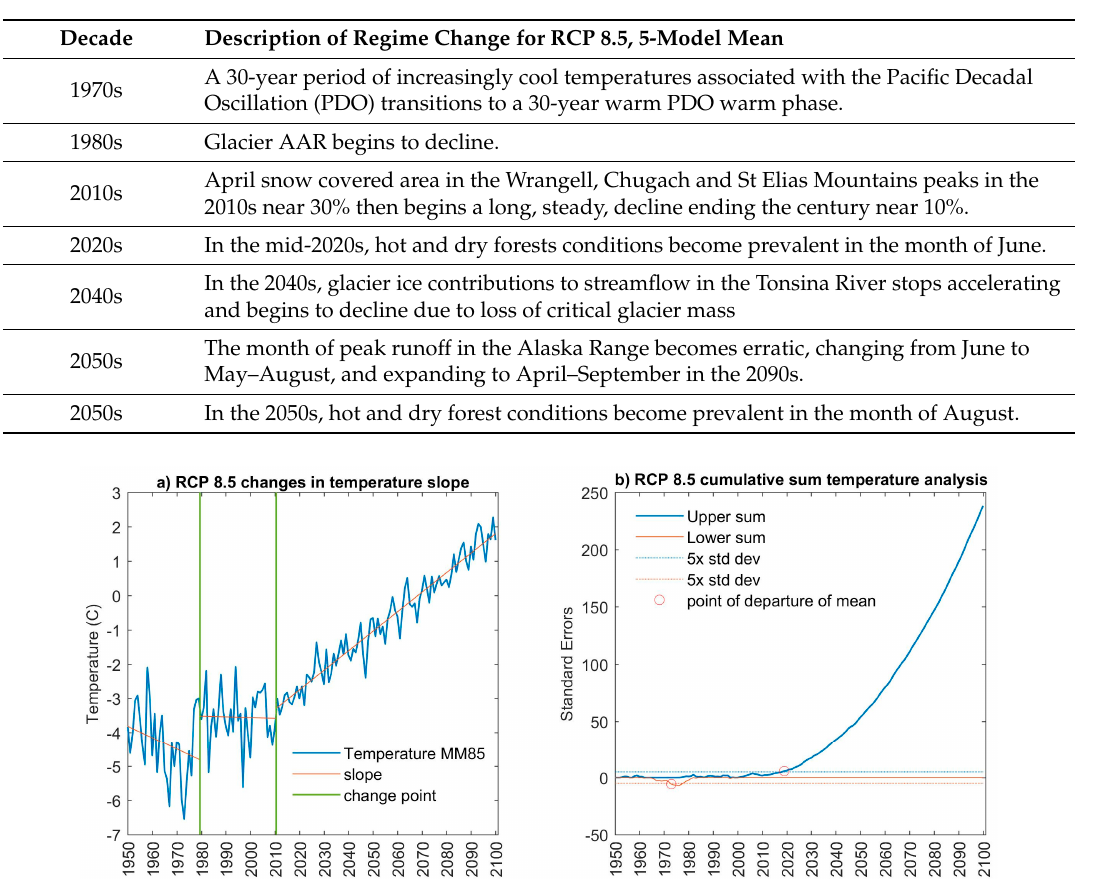
Table 5. Regime changes in the Copper River Watershed.